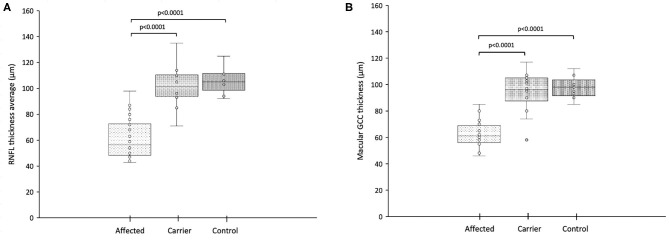
(A) Retinal nerve fiber layer thickness in the 360-degree average from LHON affected patients, LHON asymptomatic carriers and controls (each box shows the median, quartiles, and extreme values; circles represent individual subjects); (B) Total macular ganglion cell complex thickness from LHON affected (each box shows the median, quartiles, and extreme values; circles represent individual subjects).